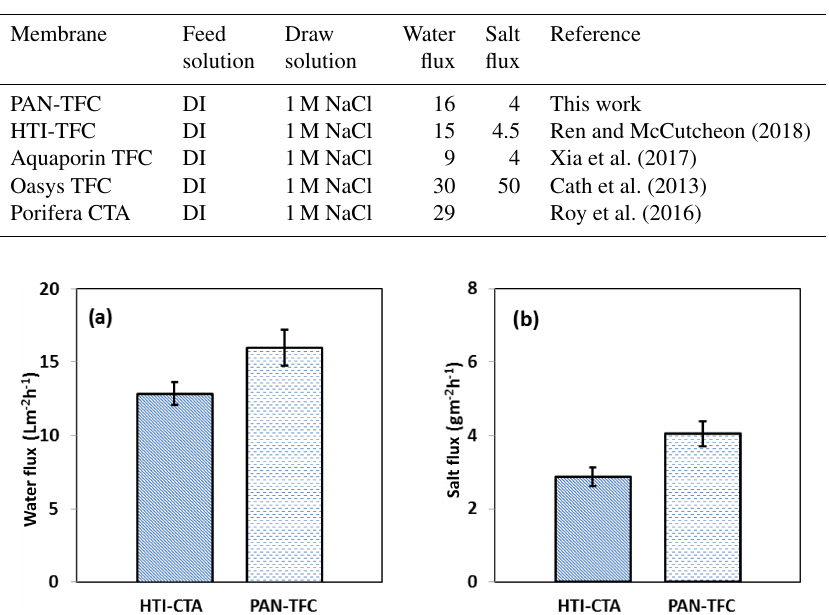
Table 2. Performance of some of the commercial FO membranes.